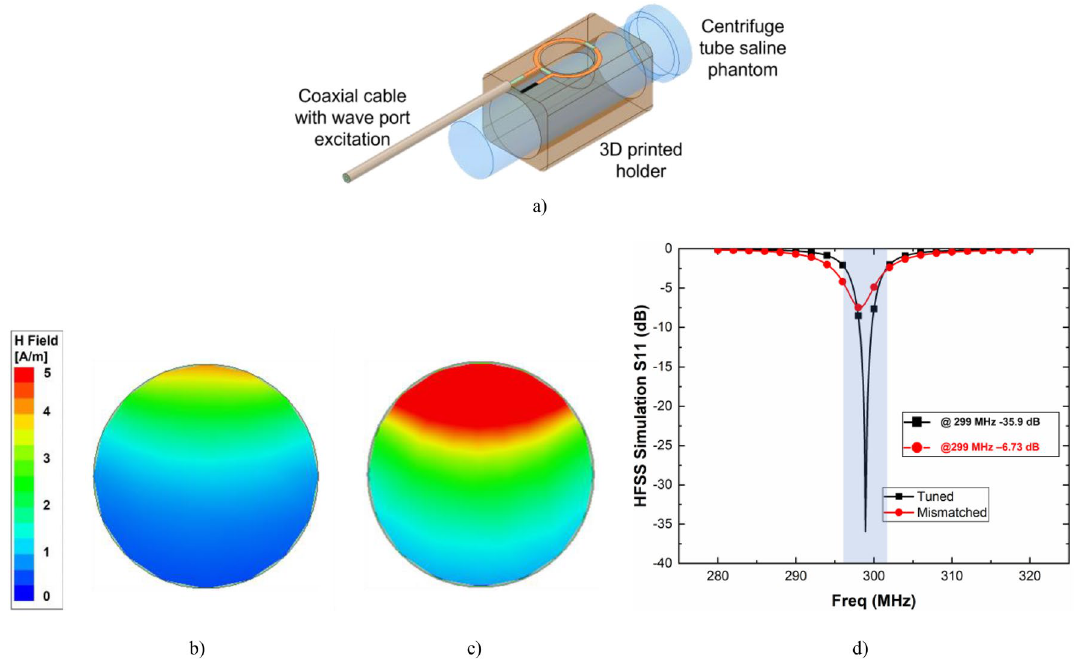
Figure 6. ( a ) Simulation setup in HFSS with 3D print housing and tube phantom ( Ansys, 3D High Frequency Simulation Software, Release 21.1, https:// www. ansys. com/ produ cts/ elect ronics/ ansys- hfss). Axial view of H-field inside the tube volume ( b ) mismatched condition due to loading and ( c ) retuned condition after loading, and ( d ) S11 plot of the HFSS simulation results for tuned and mismatched